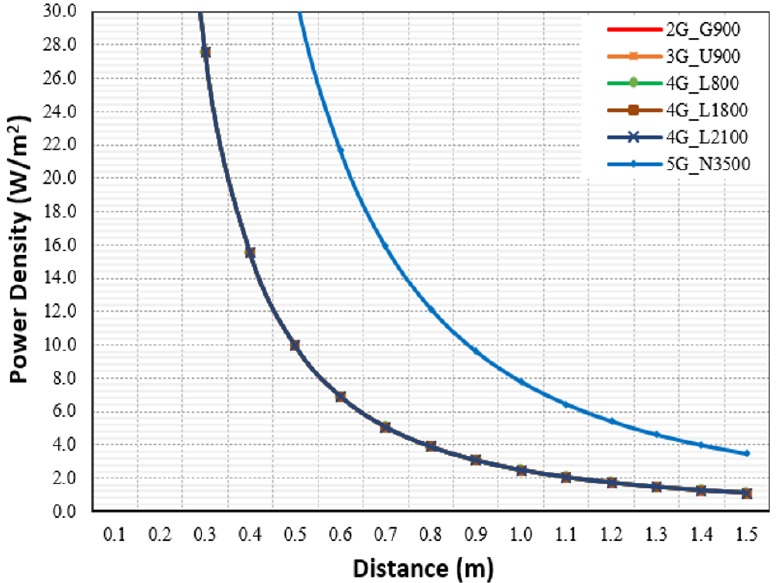
Figure 12. The PD (W/m 2 ) from the antenna for the shared IBS-DAS site. With reference to the ICNIP for the GP, Figure 13 displays the exposure ratio for each technology calculated using Equation (4) in the horizontal direction and the total TER for the IBS site shared by a single MNO, two MNOs, three MNOs, and four MNOs.